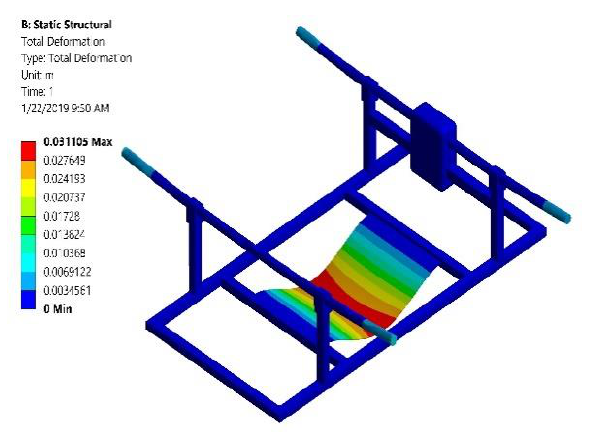
Figure 5. Deformation of UAV